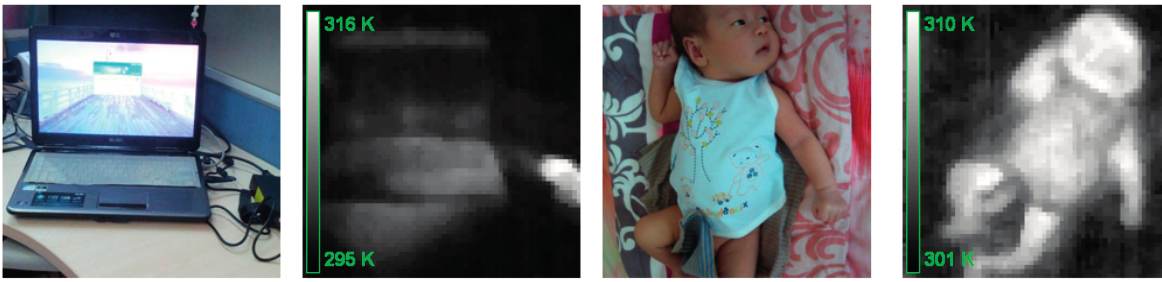
Figure 9. Thermal image captured by MTIS. ( a ) a laptop with a hot AC adapter; ( b )